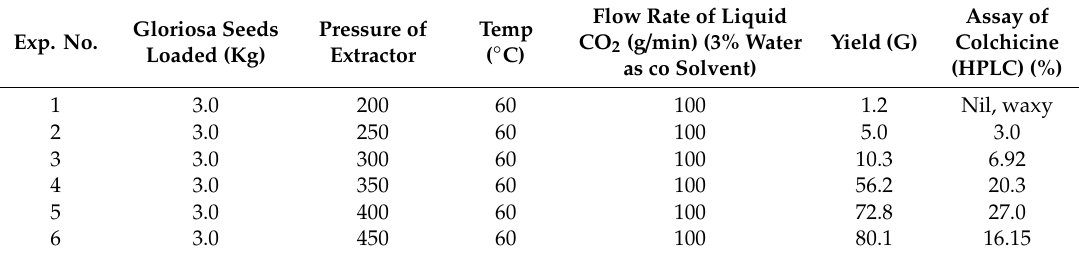
Table 1. Gloriosa superba extraction and yield